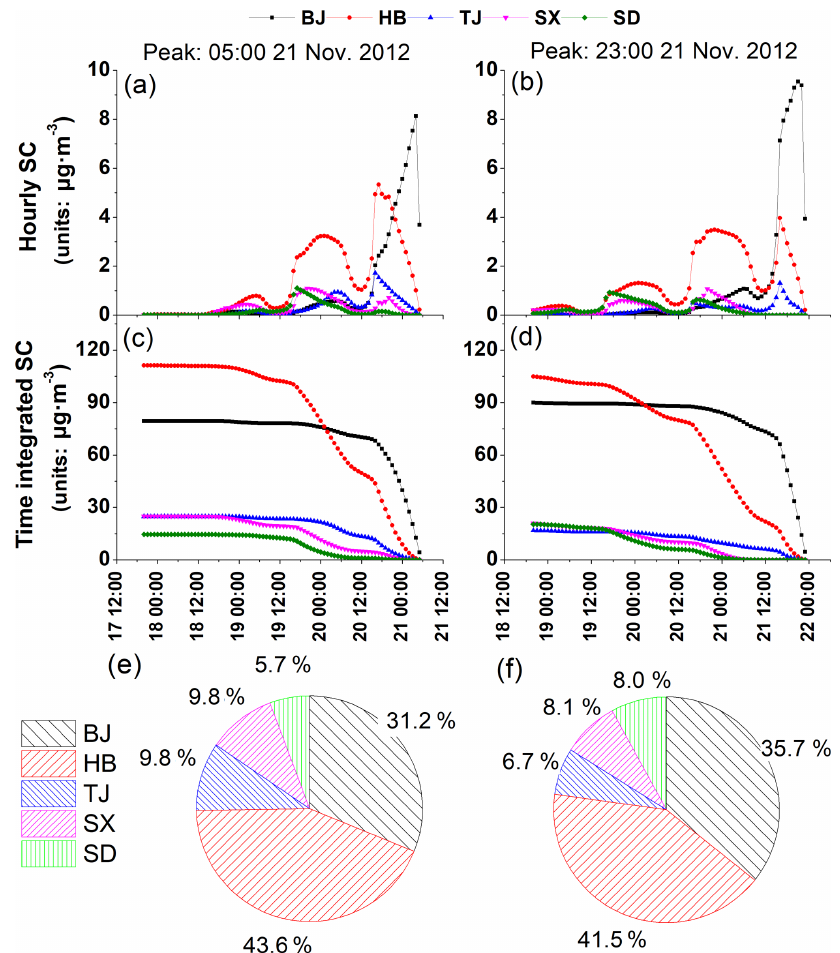
Figure 12. Sensitivity coefficients of surface PM 2 . 5 concentration peaks in Beijing to primary emission sources from local Beijing and each of the surrounding provinces. The left and right panels correspond to PM 2 . 5 concentration peaks at 05:00 and at 23:00LT on 21 November 2012, respectively. (a–b) Hourly instantaneous sensitivity coefficients to emission sources from local Beijing, Hebei province, Tianjin, and Shanxi and Shandong provinces. (c–d) The time-integrated sensitivity coefficients to local and surrounding provincial emission sources. (e–f) The contribution ratios of emission sources from each surrounding province to PM 2 . 5 concentration peaks. Please note that the date and time are given in DD HH:MM format, with all dates in November